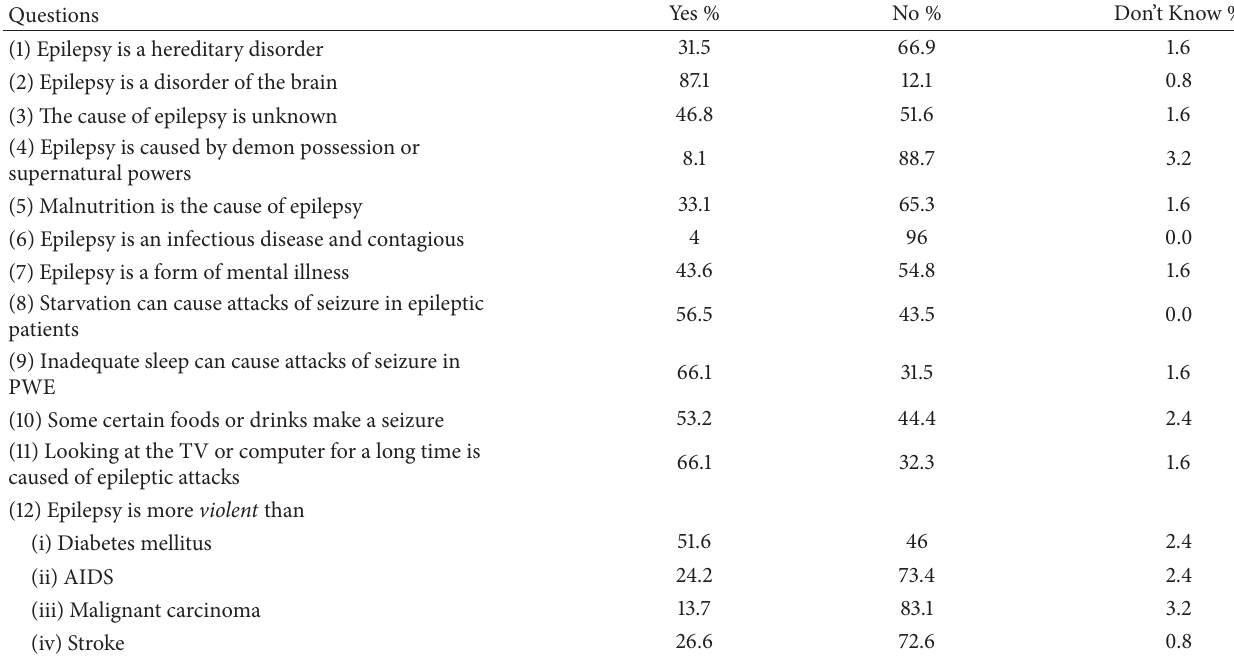
Table 2: Responses to questions on knowledge of